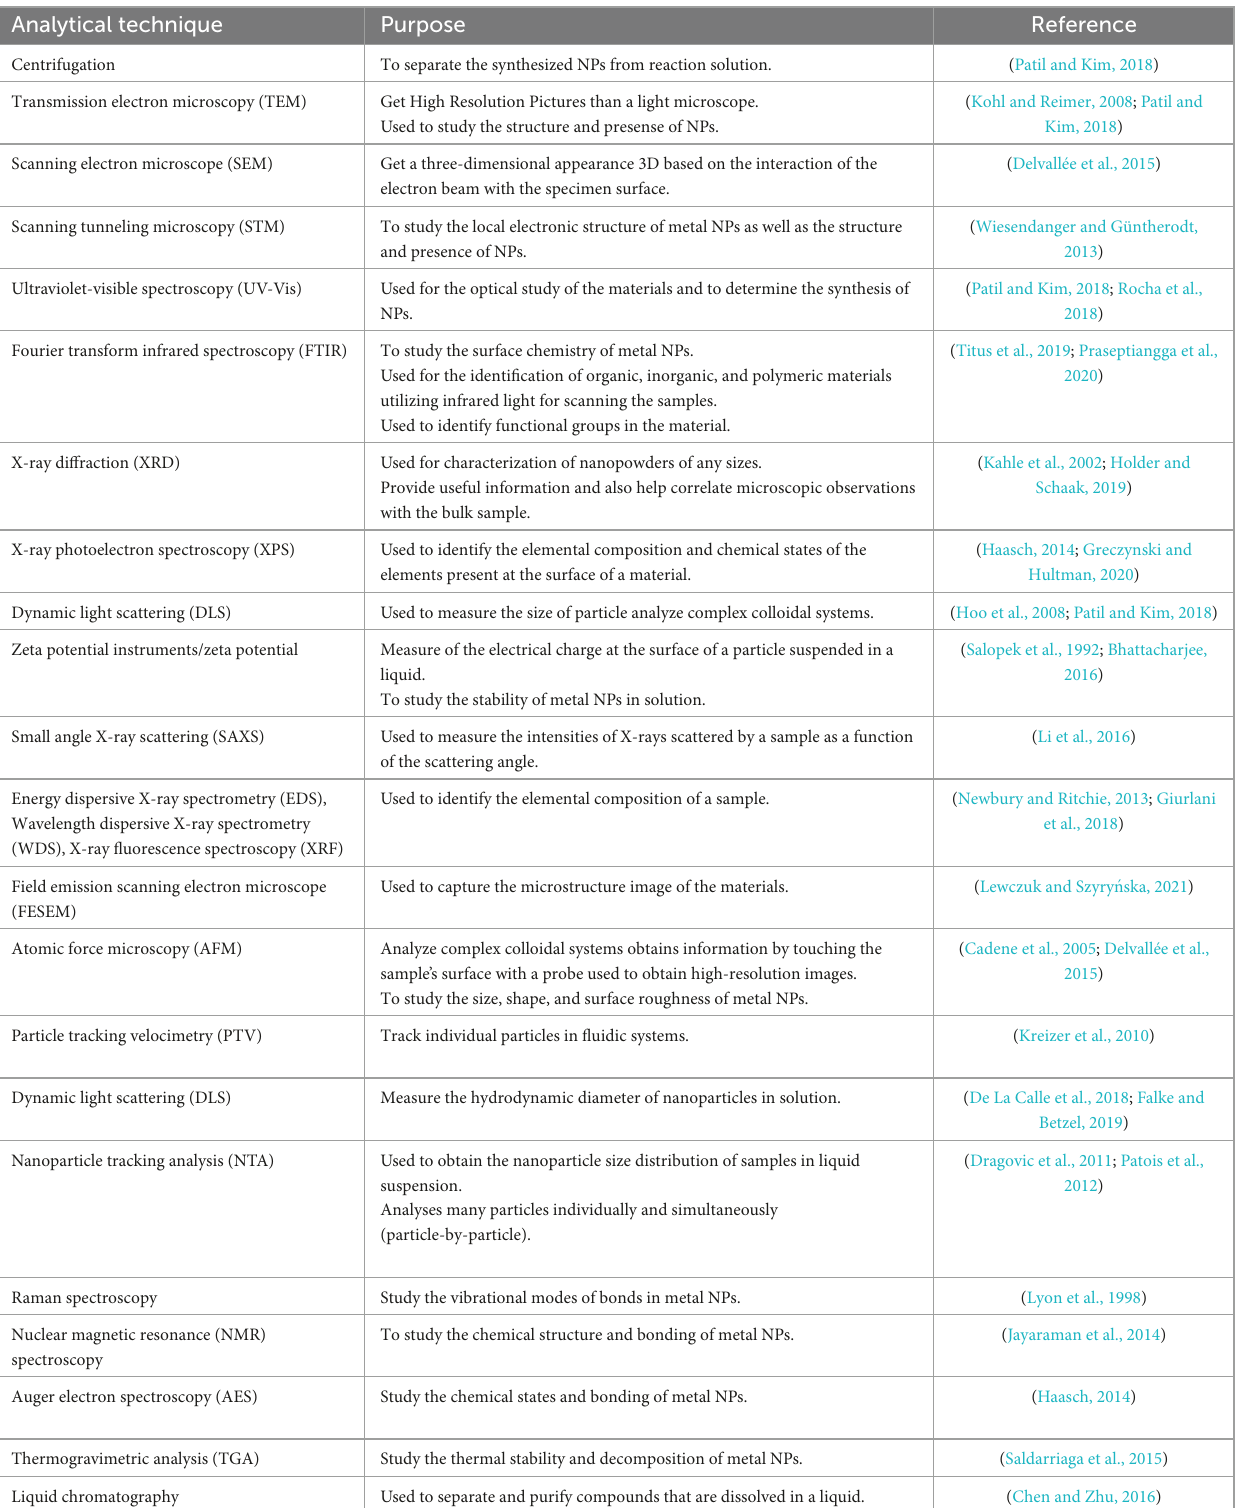
TABLE 2 Different analytical techniques and their purposes in studying